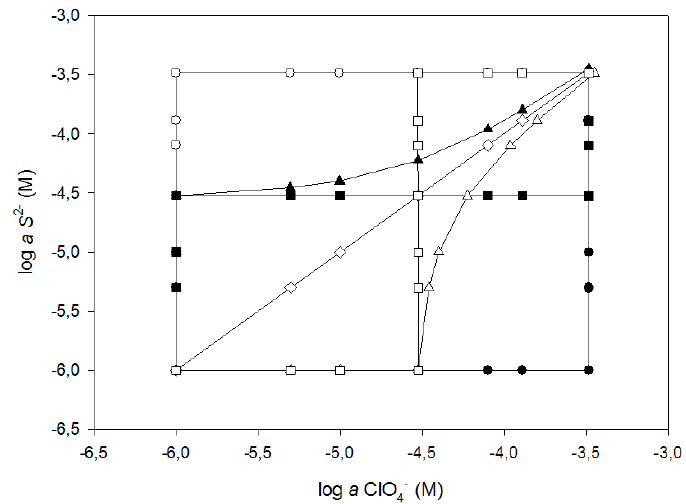
Figure 2. Visualization of the standards generated for the training of the electronic tongue , following the seven sequences of additions: 1(○), 2 (●), 3 (□), 4 (■), 5 (Δ), 6 (▲), 7 (